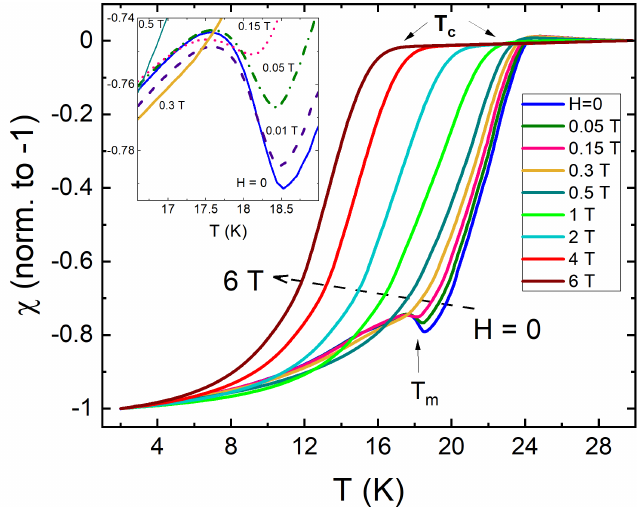
Figure 2. Normalized magnetic susceptibility of pristine EuFe 2 (As 1 − 0.23 P 0.23 ) 2 single crystal from TDR measurements at different DC magnetic fields applied along the c -axis. The inset zooms at the rapid suppression of the peak near the ferromagnetic